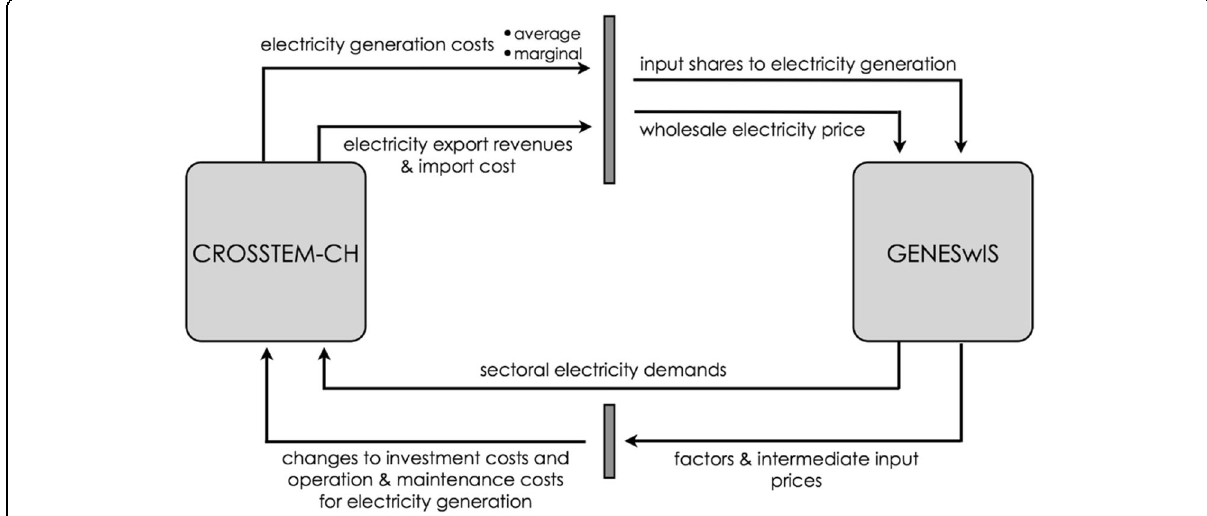
Fig. 1 Information exchange between the two component